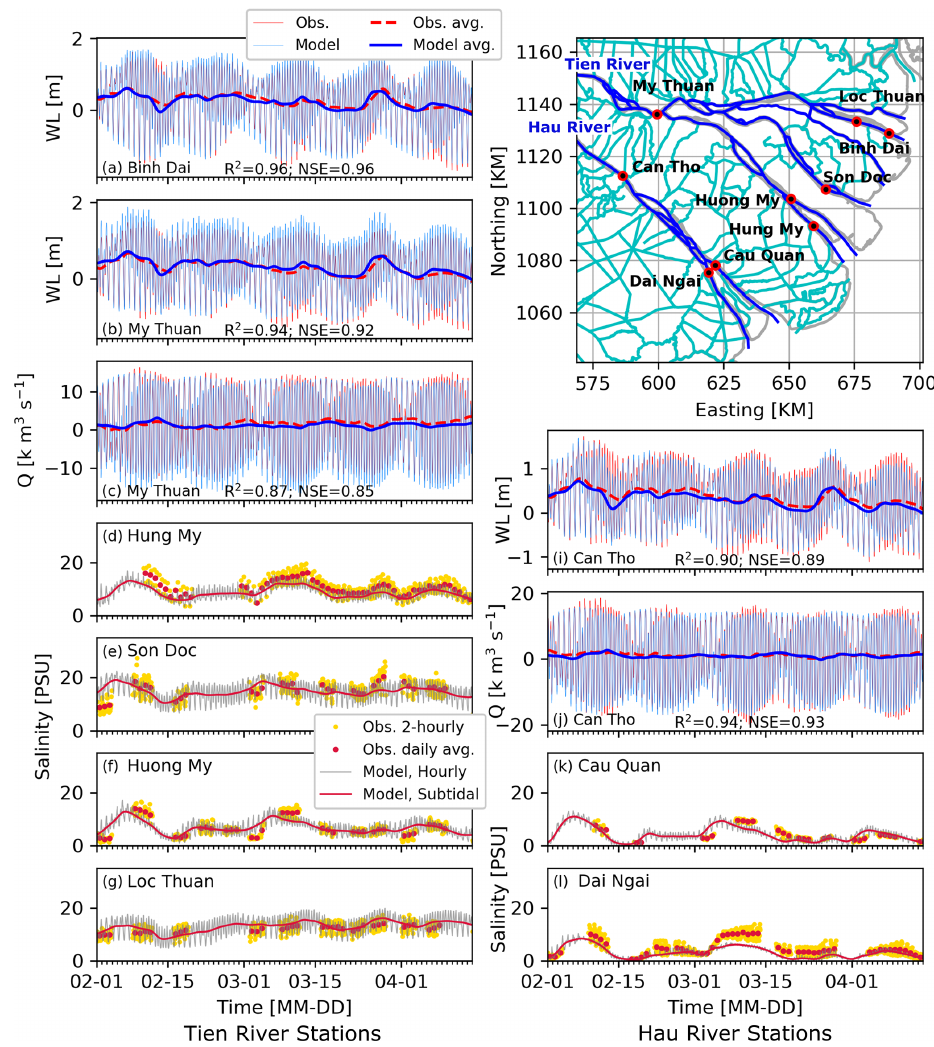
Figure 4. Model results vs. observed stationary water level, discharge, and salinity measurements at multiple stations across the Mekong